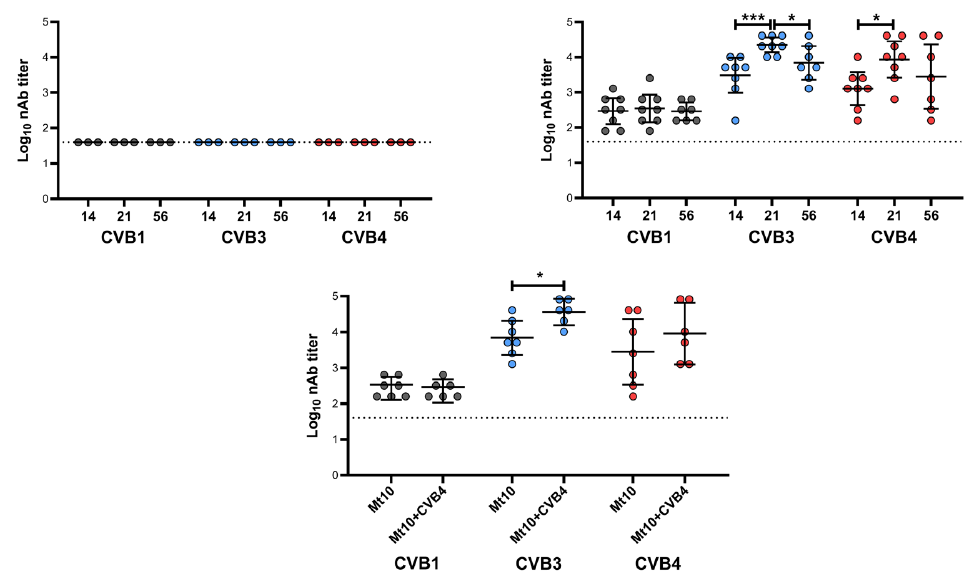
Figure 3. Mt10 vaccine induces nAbs against CVB4. Sera were collected from recipients of saline ( top left ), Mt10, ( top right ) and Mt10+CVB4 ( bottom ) on days 14, 21, and 56. Two-fold serial dilutions from 1:40 up to 1:40,960 were made, and samples were incubated with CVB1, CVB3, or CVB4. The mixtures were later transferred to plates containing monolayers of LLC-MK2 cells for CVB1 or Vero cells for CVB3 and CVB4 and incubated for 4 days to calculate the percentage neutralization based on CPE. The top left panel indicates the nAb titers determined against CVB1, CVB3, and CVB4 in the saline group that served as a baseline. The top right panel indicates the nAbs determined in the Mt10 vaccine group against CVB1, CVB3, and CVB4 at three different time points, and the profiles were compared. The bottom panel indicates the nAb titers determined in the Mt10 vaccinated/CVB4 challenged group and the profiles were compared with those of Mt10 vaccine group at termination (day 56). Data from n = 3 – 8 samples are shown. Two-way ANOVA with Sidak’s post-test was used to compare significance of nAb titers. * p ≤ 0.05 , *** p ≤ 0.001 .